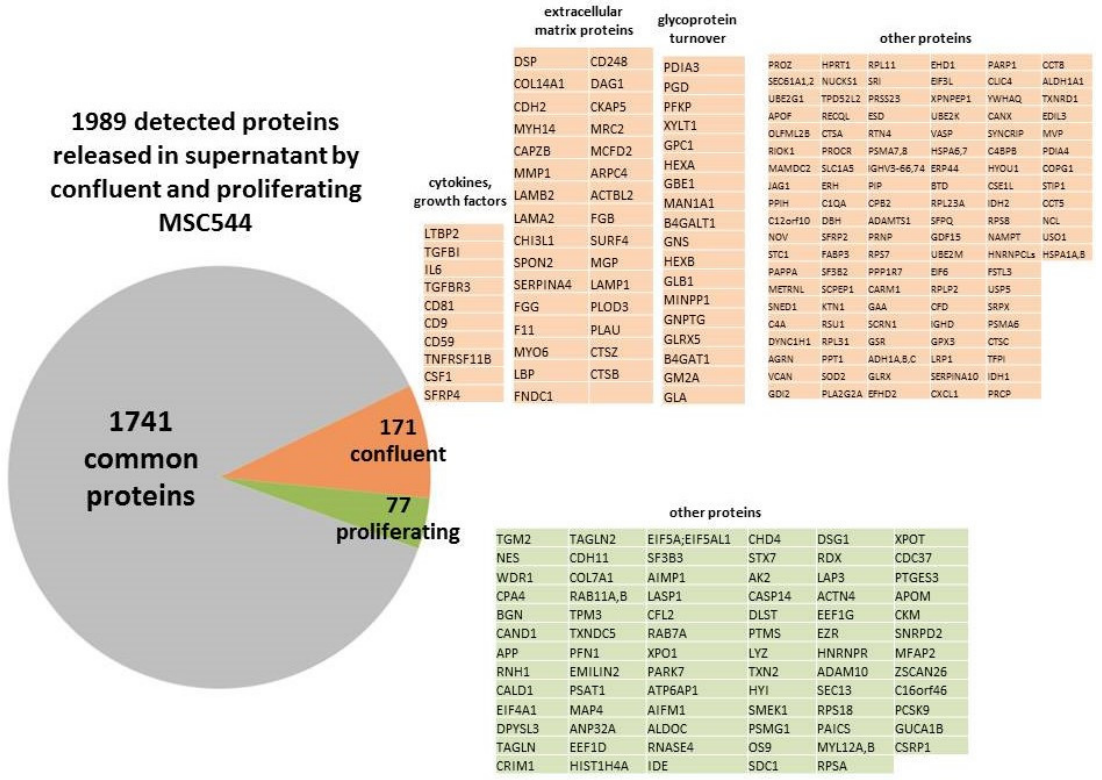
Figure 4. Proteomics analysis was performed by LC-MS of 36h cell culture supernatant following secretion of proteins from steady-state proliferating MSC544 in comparison to a corresponding 36h release of proteins from confluent MSC544 after permanent culture for 189d. Gene names of the proteins are presented in the tables whereby 171 secreted proteins identified from the confluent MSC544 cell culture (orange tables) were further distinguished by functional groups with little if any corresponding functionalities in the released proteins from proliferating MSC544 (green table).